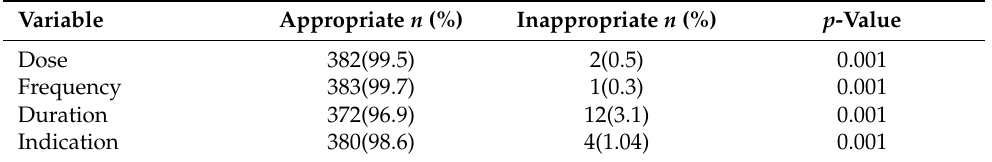
Table 6. Appropriateness of the prescribed antibiotics by dose, frequency, and duration of